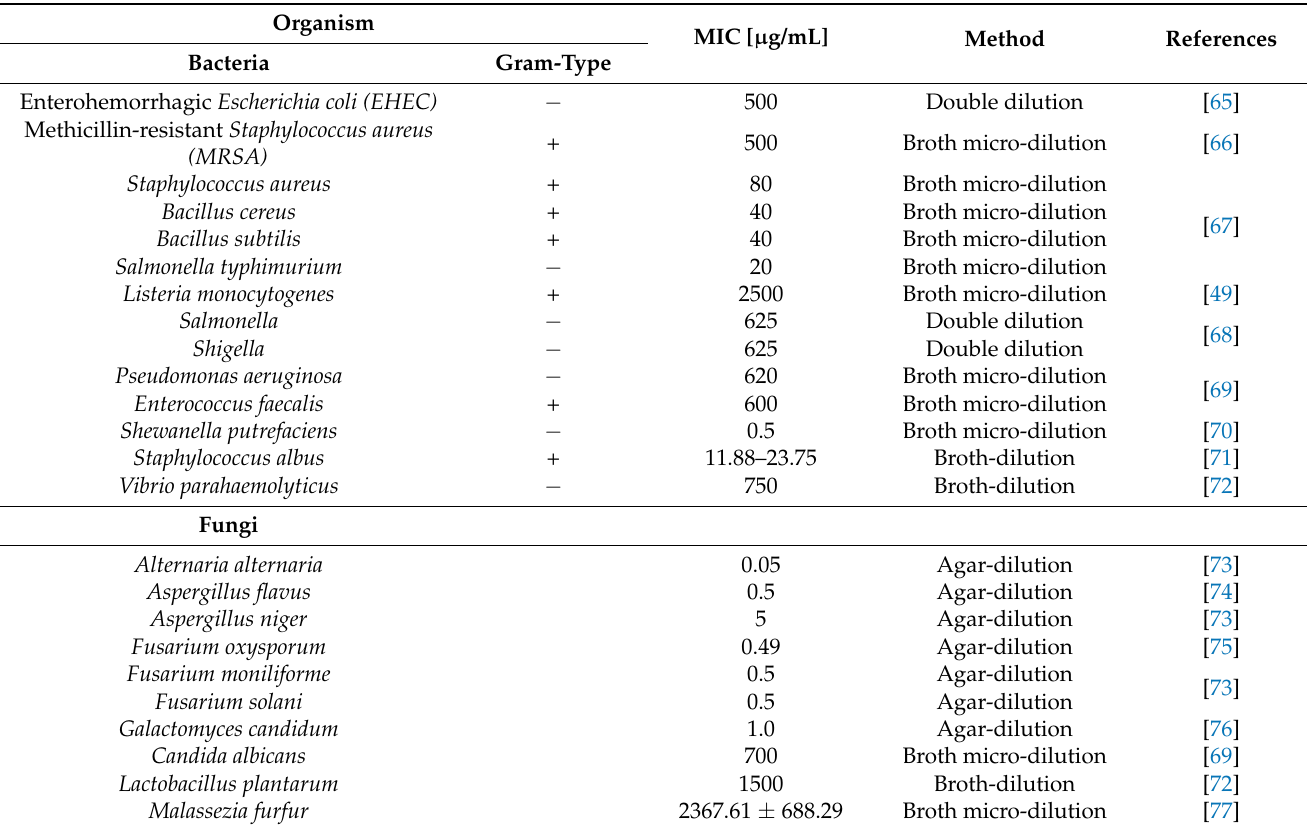
Table 3. Minimal inhibitory concentrations (MICs) of Litsea cubeba essential oil against different bacteria and